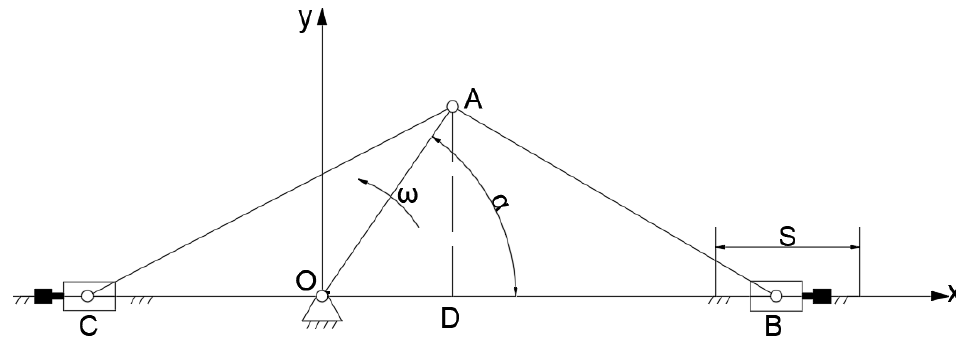
Figure 3. Schematic diagram of the motion and force of the Crank double-slider mechanism.